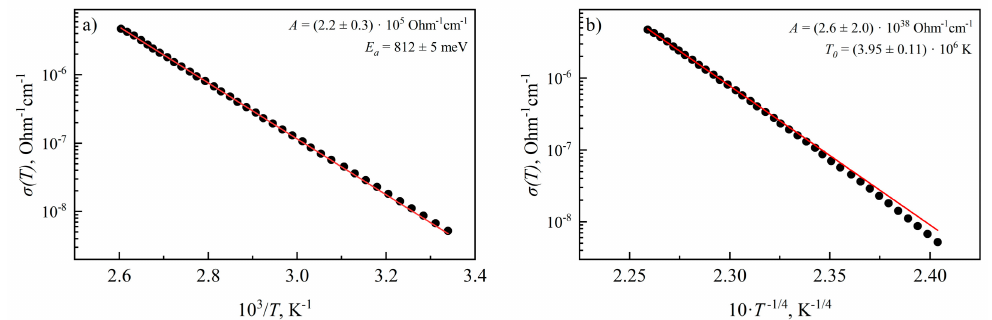
Figure 2. The temperature dependence of the dark conductivity in the coordinates for approximation by ( a ) activation dependence, ( b ) Mott’s